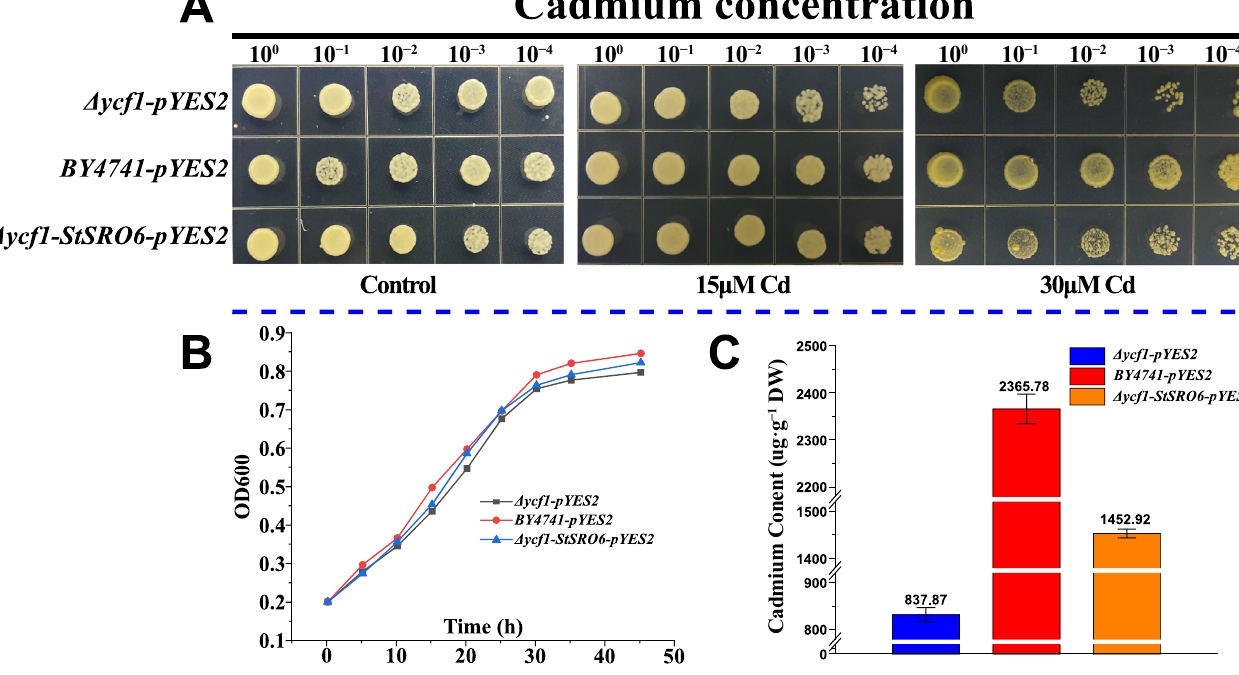
Figure 7. Analysis of Cd tolerance function of StSRO6 heterologous expression in eukaryotic cells. ( A ) Wild-type yeast strain BY4741 (positive control), cadmium-sensitive mutant Δ ycf1 (negative control), and overexpressed StSRO6 - Δ ycf1 strain were dilution (10 0 , 10 − 1 , 10 − 2 , 10 − 3 , 10 − 4 ) cultured in different Cd content (0, 15, and 30 μ M) on synthetic galactose-uracil (SG-U)deficiency minimal medium, thus after 7 days, the growth phenotypes of the different strains were observed. ( B ) Biomass changes of three yeast strains at different time points. ( C ) Detection of Cd content in three yeast strains after stable growth (7 d).